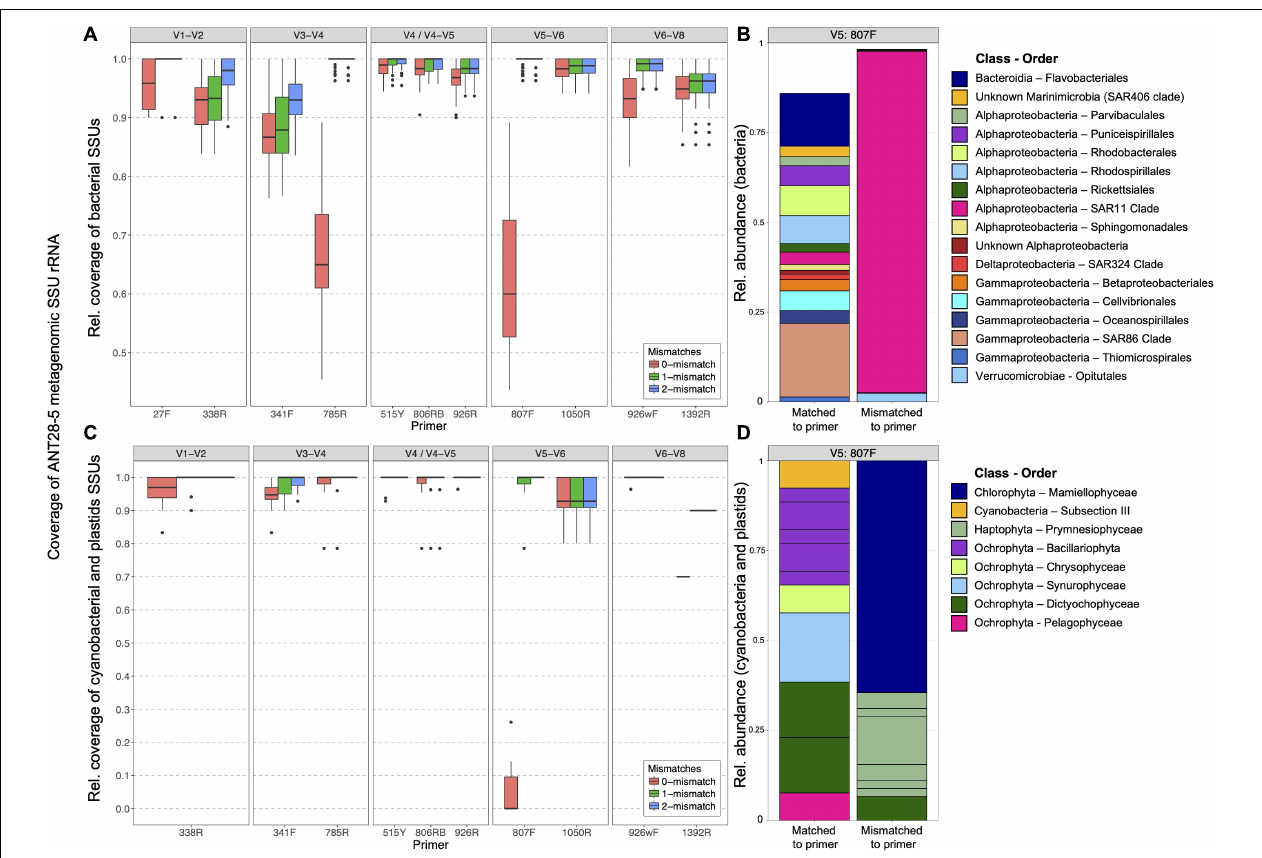
FIGURE 2 | In silico analysis of the matching efficiency of primers for retrieving 16S genes from ANT28-5 metagenome libraries. Matching efficiency for Bacteria (A) and chloroplasts (C) of primers for the conserved regions V1 to V9 to the metagenome libraries from Polarstern ANT28-5 allowing 0, 1, or two mismatches. Relative abundance of bacterial taxa (B) and chloroplasts (D) that matched (left) or did not match (right) to primer 807F. SSU fragments were extracted from the metagenomes using phyloFlash and sorted into four categories (Archaea, cyanobacteria + chloroplasts, Bacteria, and Eukarya). Each category was set to 100% and the number of hits with the respective primers was determined allowing 0, 1, or 2 mismatches. The expected performance of a given primer pair is determined by the worse of the two primers, e.g., V5-V6 is expected to hit only about 60% of the bacterial rRNA gene sequences while V4-V5 about